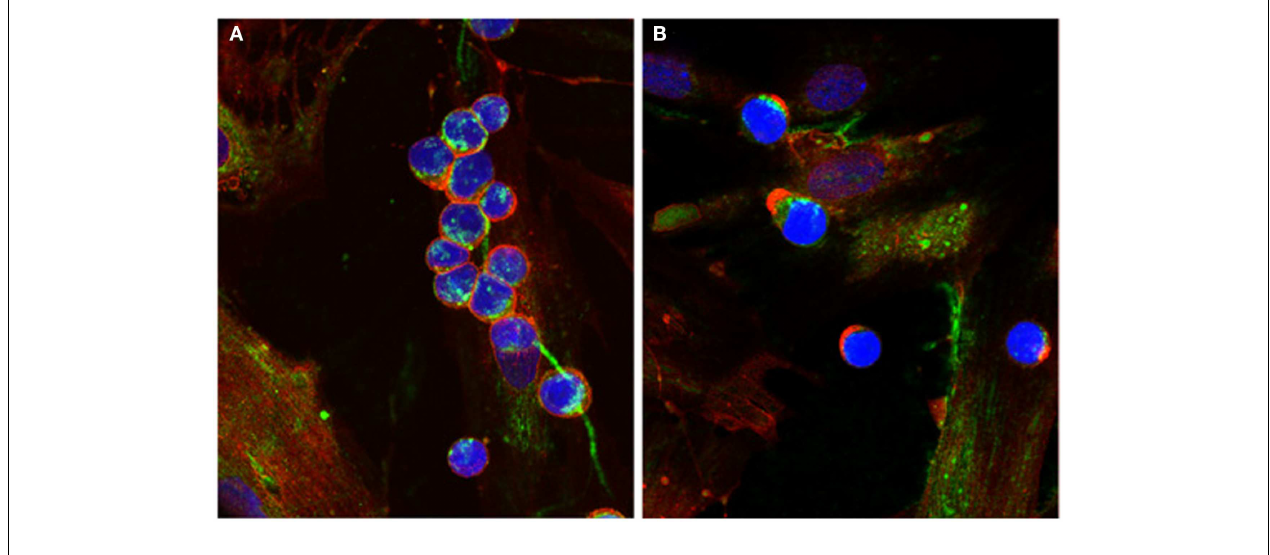
incubation at 37°C, CD44 (red) is capped to one pole on the leukocytes, HA cables appear ragged (center panel) and HA is internalized. (Nuclei are